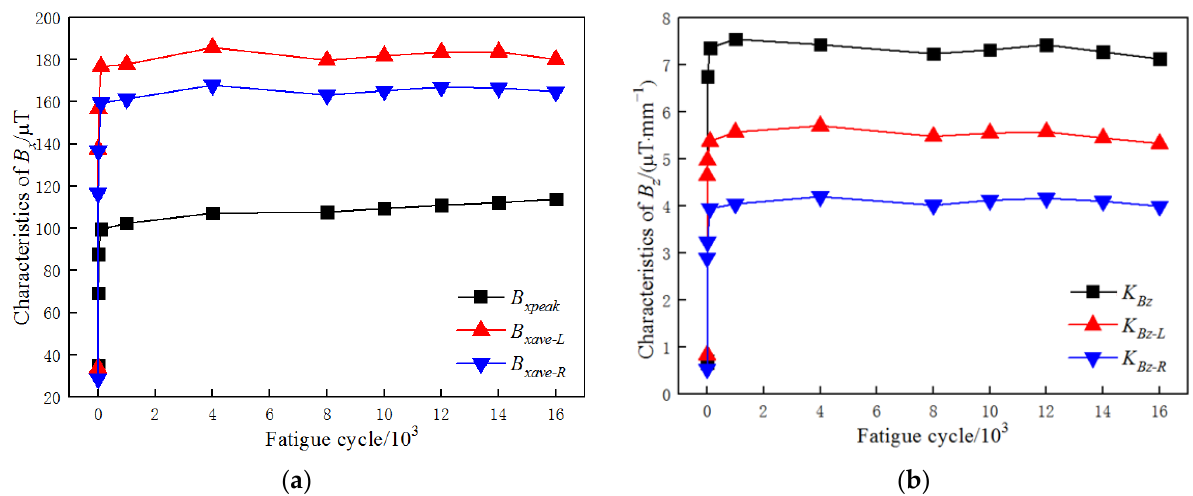
Figure 4. Characteristics variation of ( a ) B x signals and ( b ) B z signals during the fatigue test.